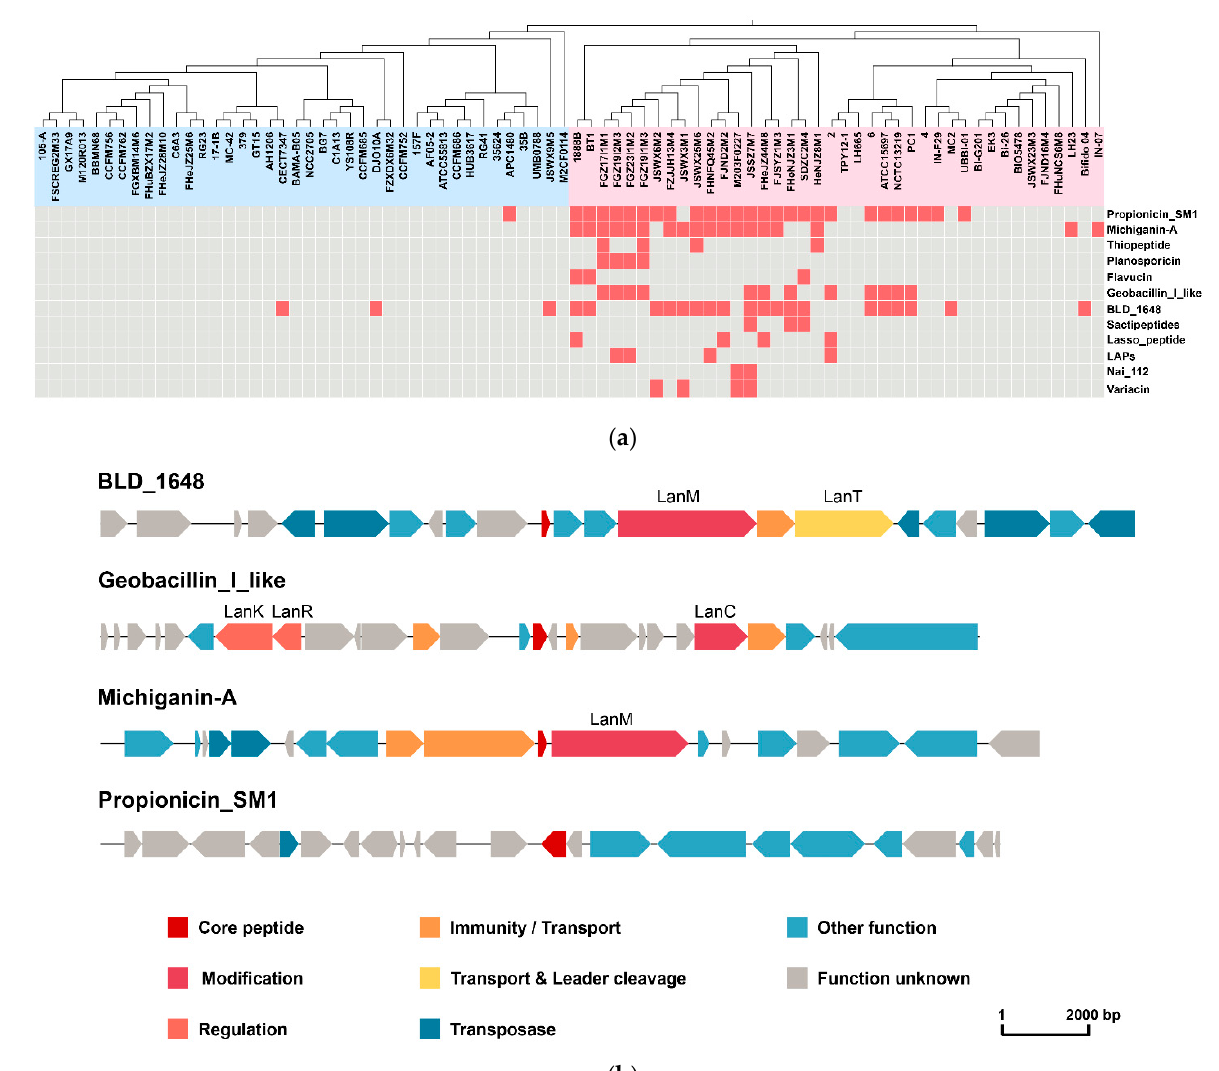
Figure 10. Predicted bacteriocins in B. longum: ( a ) Bacteriocins distribution of B. longum . The horizontal axis represents the genomes which were clustered according to the phylogenetic tree. The vertical axis represents bacteriocins predicted in B. longum . The blue area represents B. longum subsp. longum and the red area represents B. longum subsp. infantis. Red indicates present, while grey indicates absents. ( b ) Four predicted bacteriocin structures of B. longum .